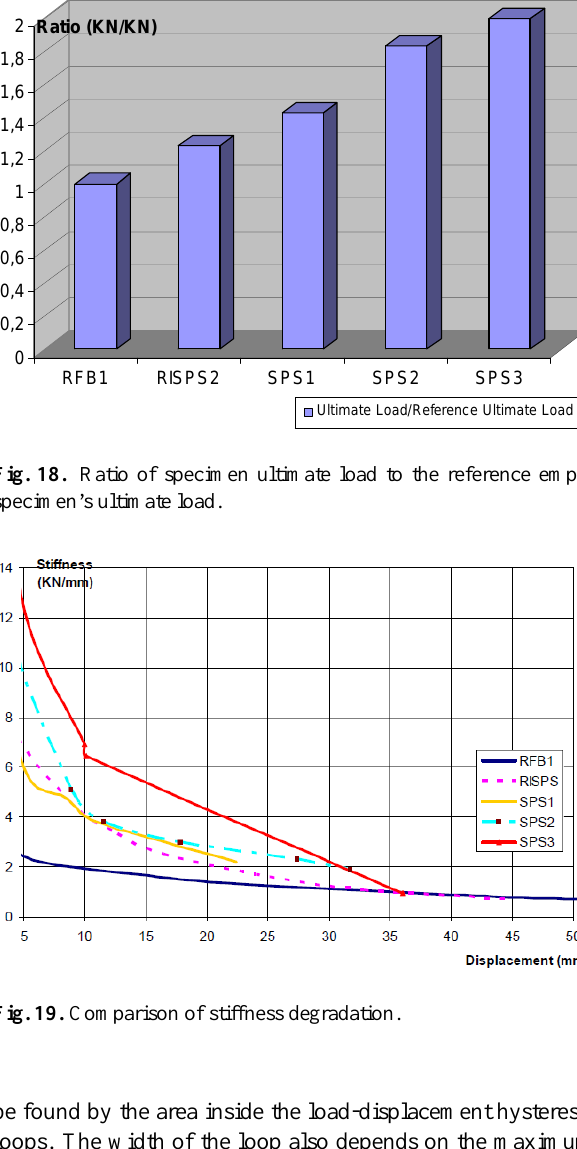
Figure 16 Hysteresis curves of specimen SPS3